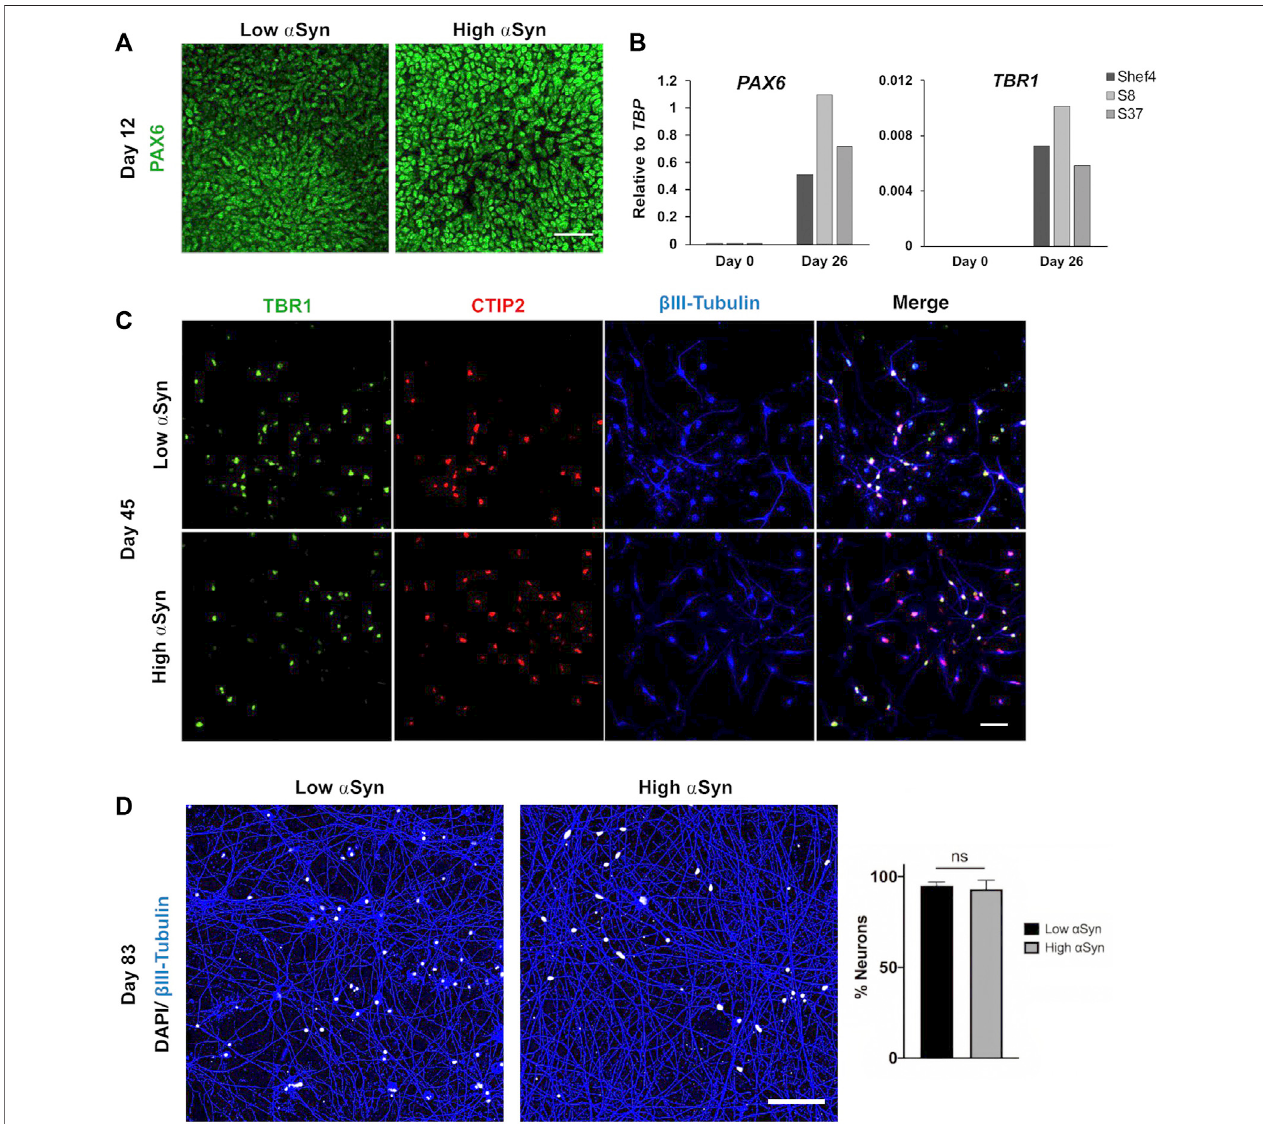
FIGURE 3 | Level of α Syn does not impair cortical neuron differentiation. (A) Representative immunocytochemistry images at day 12 of low α Syn and high α Syn hESCs differentiated into neuroectoderm, immunostained for the cortical progenitor marker PAX6. Scale bar = 50 µm. (B) Quantitative RT-PCR for PAX6 and TBR1 expression for Shef4 (control), S8(high α Syn), and S37 (high α Syn) samplesat day 0 (self-renewing hESCs) and day 26 ofcortical differentiation. Mean expression levels are shown relativeto the expression of TBP . (C) Representative immunocytochemistry images of both low α Syn and high α Syn immature neurons (day 45) stained for the deep cortical layer markers TBR1(green), CTIP2 (red),and β III-Tubulin(blue), aswell asmerged images. Scale bar = 50 µm. (D) Immunocytochemistry images of neuronal networks representing both low α Syn and high α Syn hESCs differentiated into mature neurons (day 83), immunostained for the neuronal marker β III-Tubulin (blue) and DAPI (white). Scale bar = 100 µm. Percentage neurons was calculated by quantifying DAPI levels relative to β III-Tubulin. Signi fi cance performed using a Welch ’ s t -test. N =number ofbiologicalreplicates(differentiatedcell line)and n =technicalreplicates(numberofwells percellline) ( N =2, n =5forlow α Syn; N =3, n =8 for high α